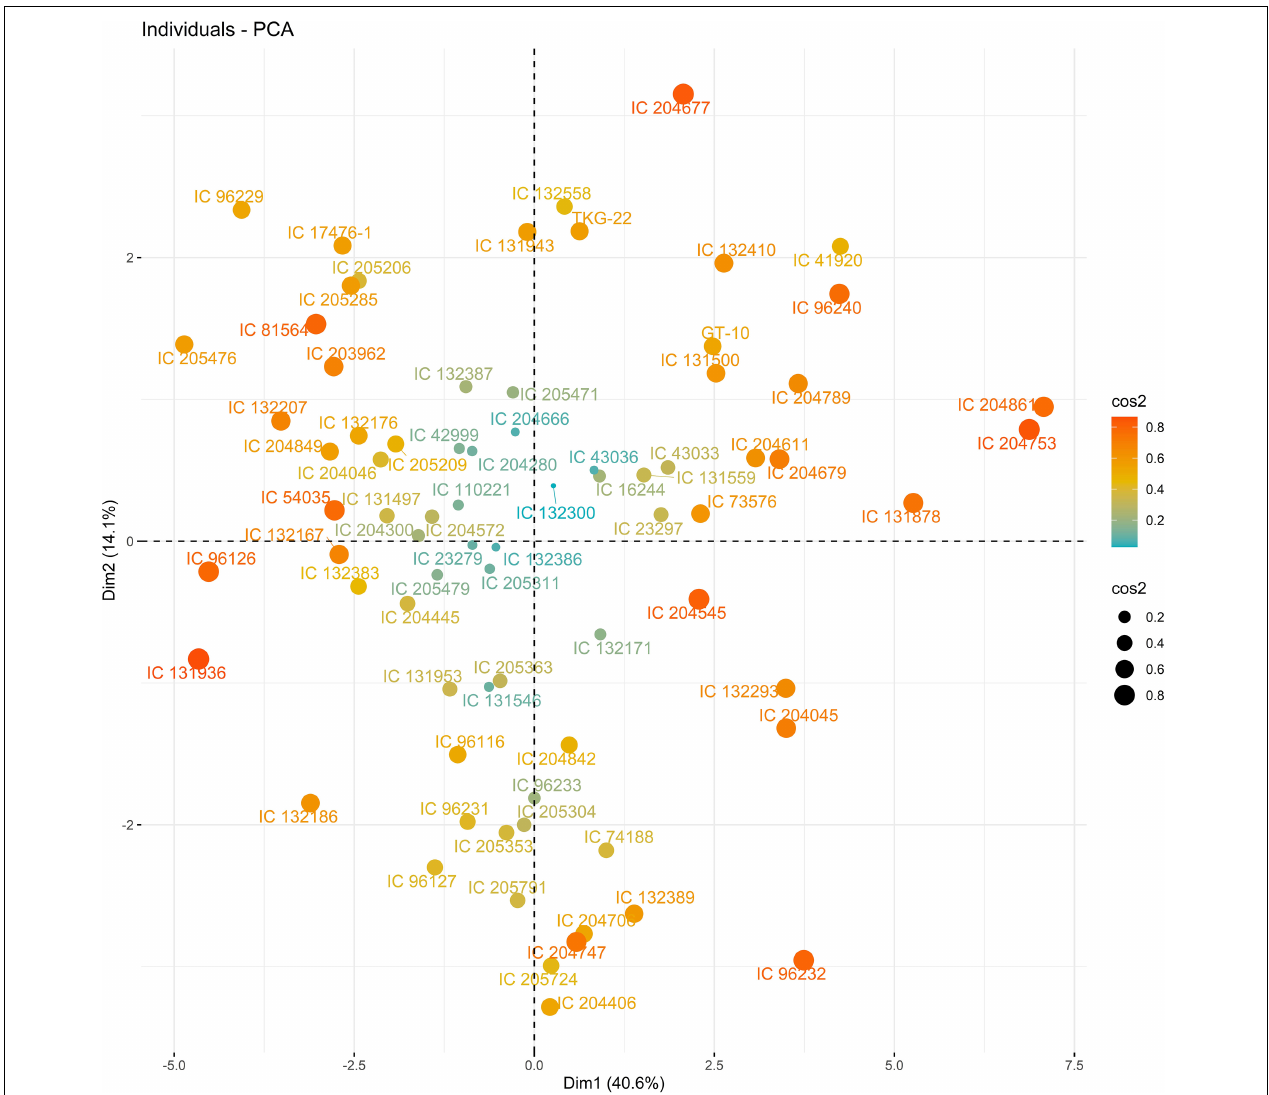
FIGURE 7 | Principal scatter plot of the first two principal component analysis (PCA) of 76 sesame genotypes during year 2019 under well-watered (WW)